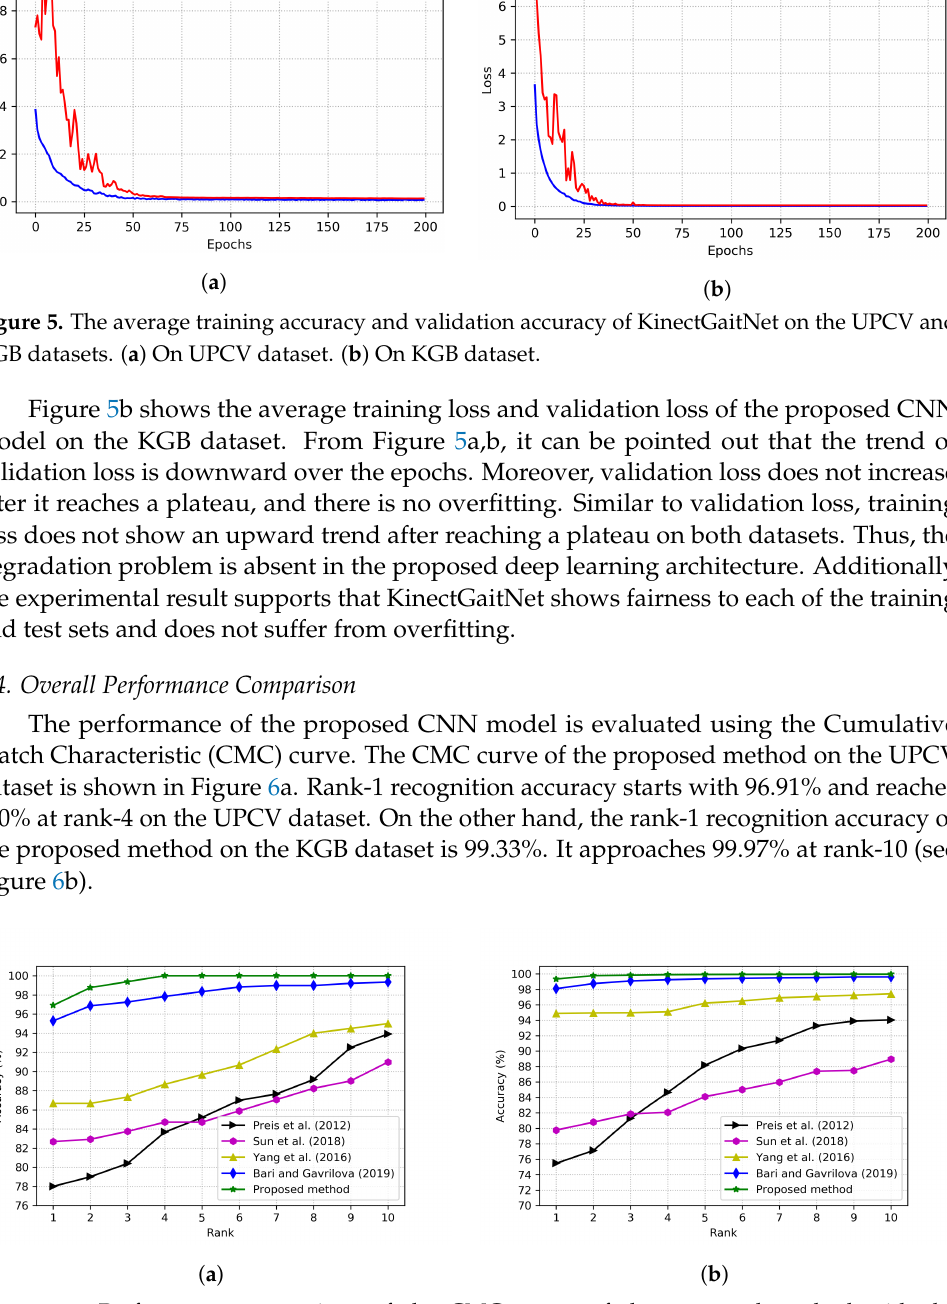
Figure 6. Performance comparison of the CMC scores of the proposed method with the methods [4,5,23,26] on the UPCV and KGB datasets. ( a ) On UPCV dataset. ( b ) On KGB